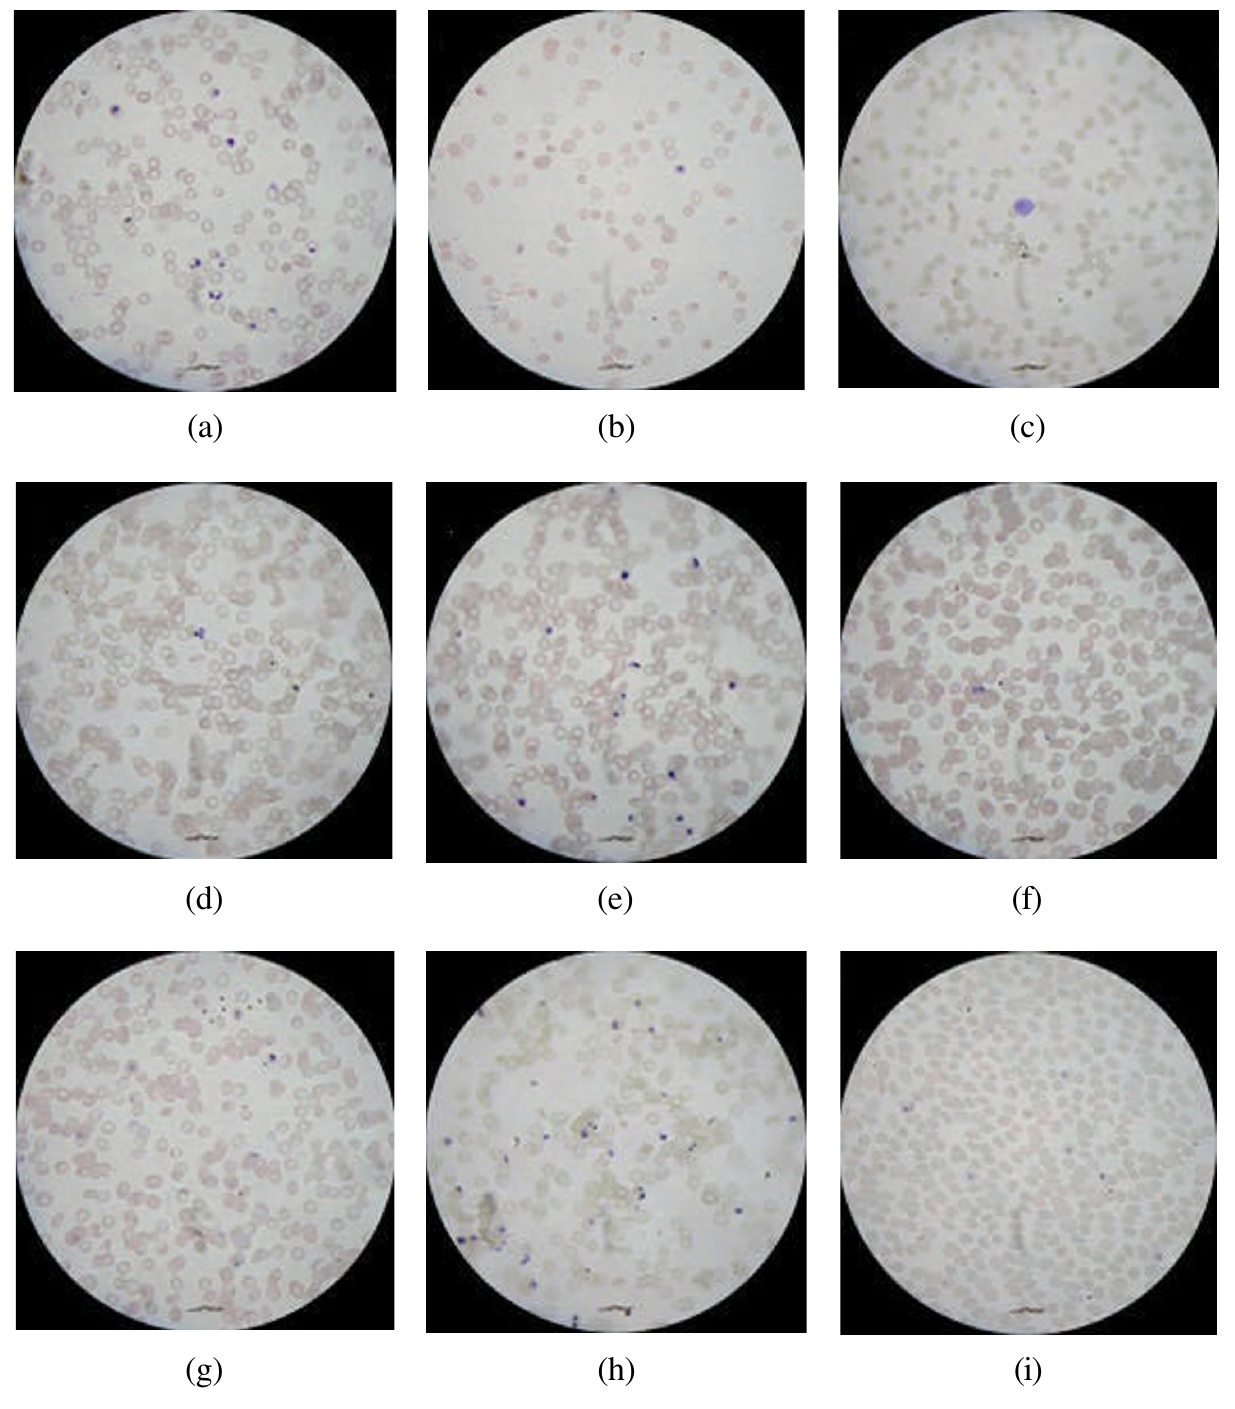
Figure 3 Randomly selected test images of blood smears . (a)-(i) Test images (print size does not reflect actual imagery